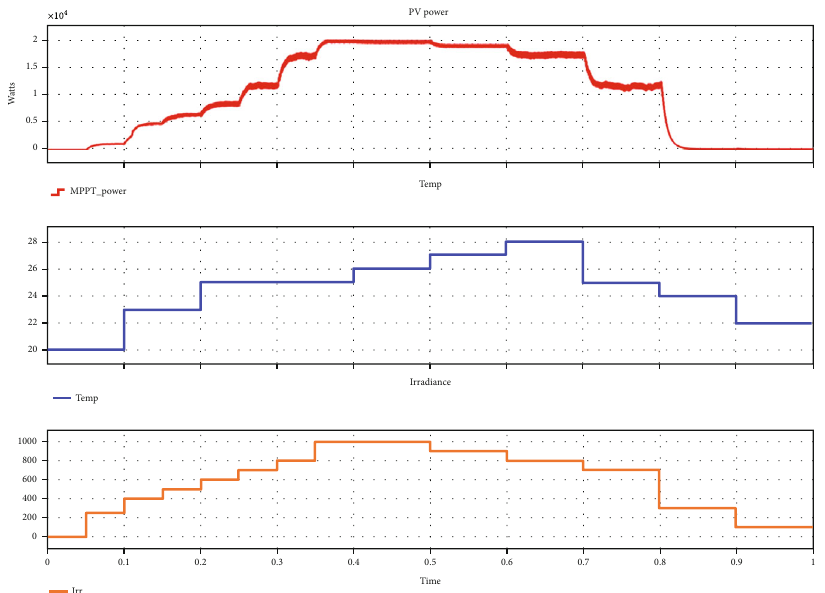
Figure 9: Simulation results of DNN-PV MPPT power with respect to irradiance and temperature.